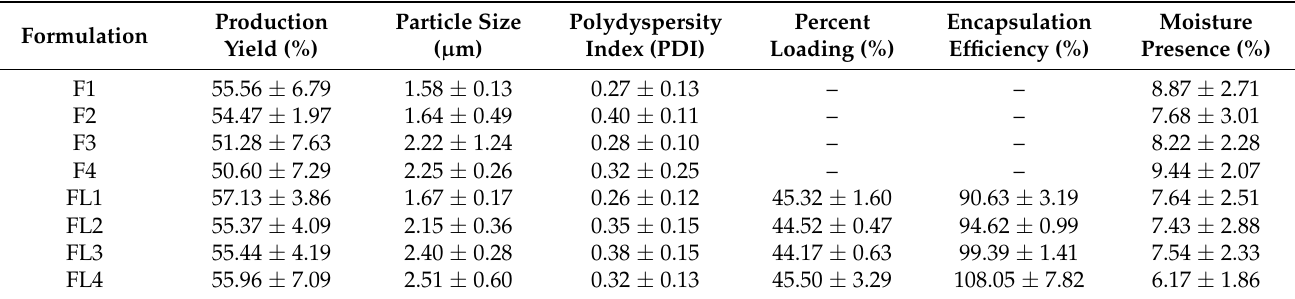
Table 2. Quality determination of ALG and ALG/GEL microparticle placebos (F1–F4) and ALG and ALG/GEL LUL-loaded microparticles formulations (FL1–FL4) (mean ± SD, n =